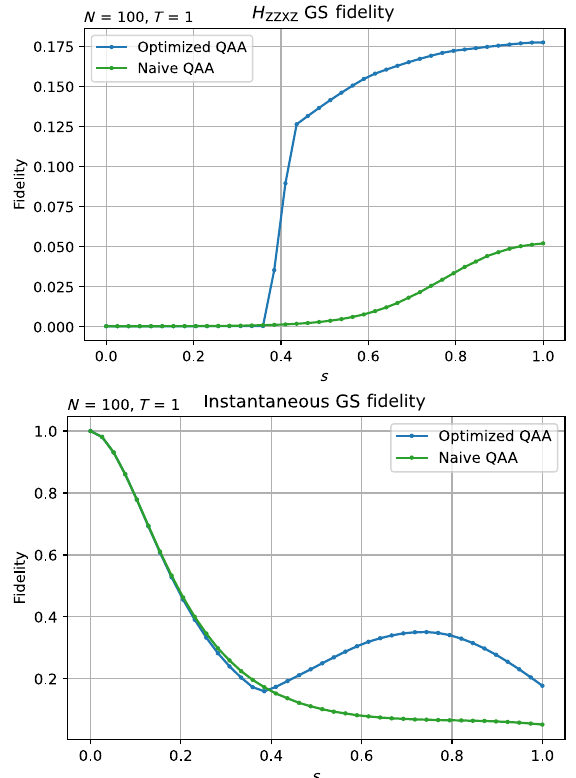
FIG. 13. The ground-state fidelity is plotted along the adia- batic path for different values of s . The results are for N = 100 and fixed total time T = 1. The optimized QAA curve (blue) dif- fers significantly from naive QAA (green curve) in the region of very small chunks around s ≈ 0.4. Note that the spectral gap between the ground state and the first excited state is not min- imal in this region but decreases strictly monotonically with s .